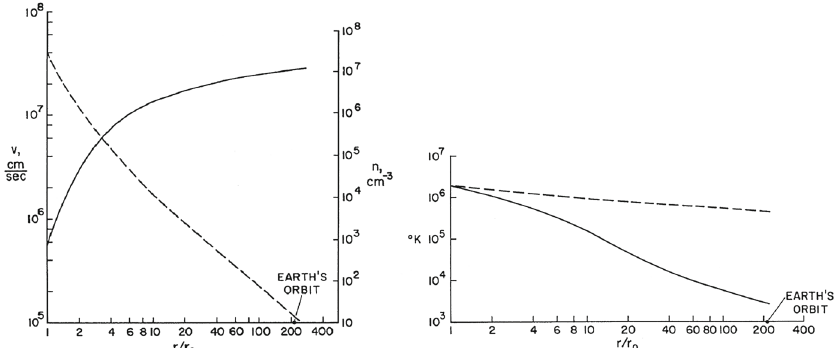
Fig.8 Leftpanel:flowvelocity(solidline)andelectrondensity(brokenline)asafunctionofradialdistance (in units of solar radii) from the center of the Sun. Right panel: electron (broken line) and ion (solid line) temperatures as a function of radial distance. Image reproduced with permission from Sturrock and Hartle (1966), copyright by